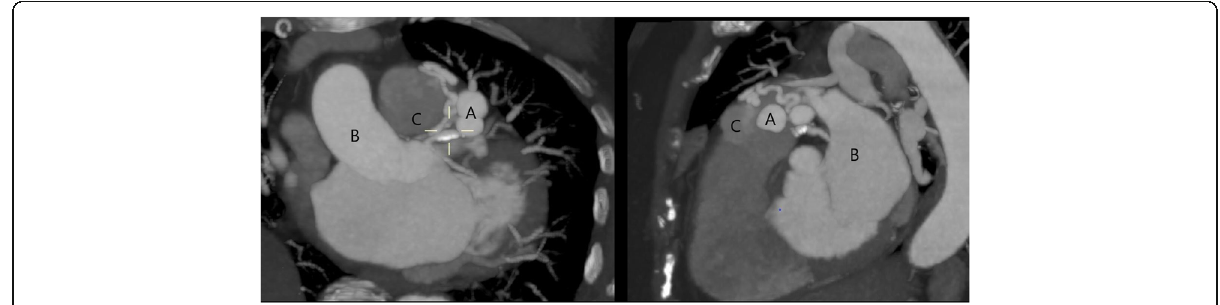
Fig. 2 Multiplanar reformat (MPR) images of the coronary CTA demonstrating: a inflow aneurysms from LADD and artery fistula, b aorta, c pulmonary artery with a subtle contrast blush as a result of abnormal communication from LADD to